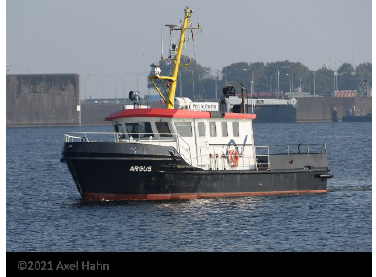
Figure 7. NPorts Port operation ship